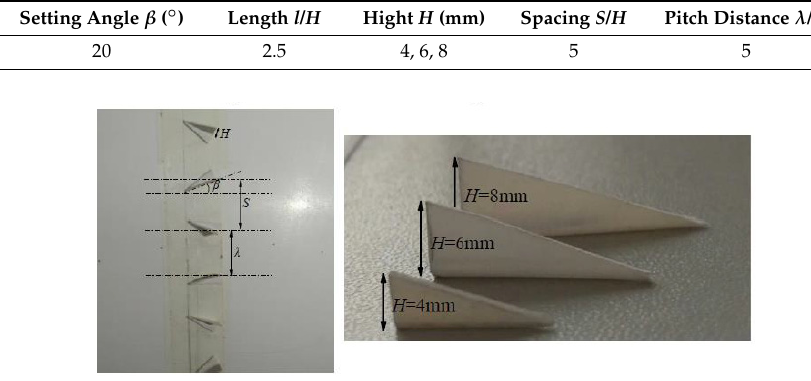
Figure 6. VG arrangement and VG height.